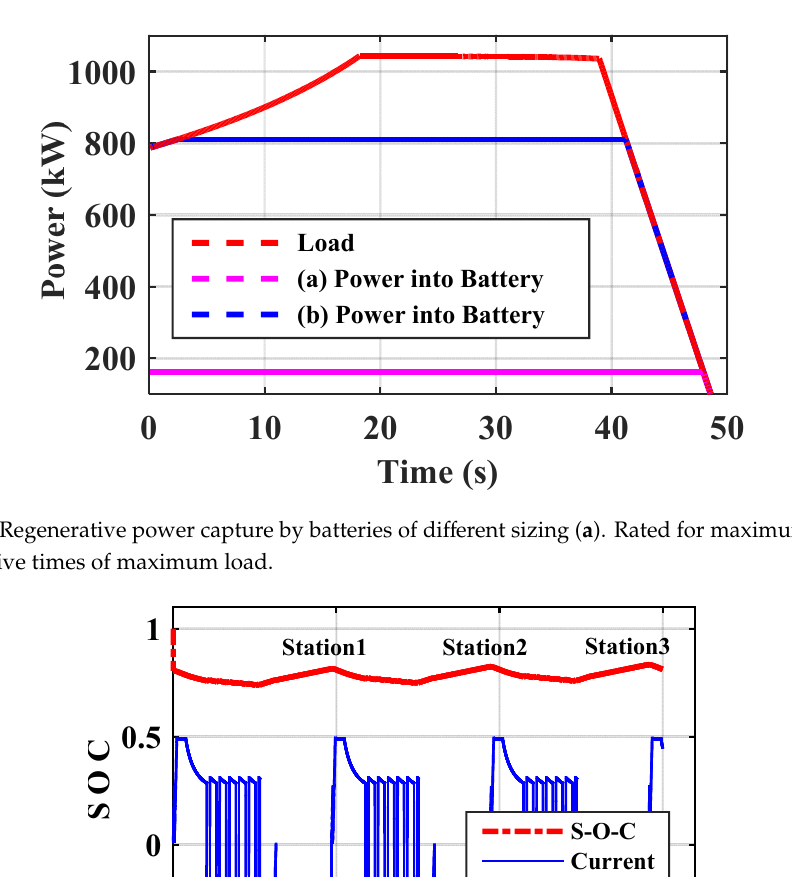
Figure 14. Battery’s state of charge with actual load profile scaled (sized for maximum load).